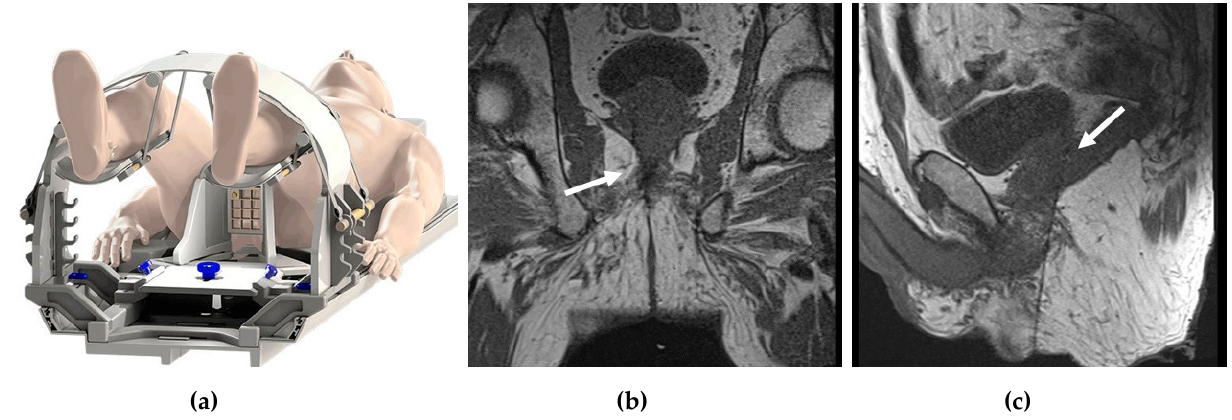
Figure 1. In-bore transperineal biopsy: ( a ) diagram of a patient placed supine in an MRI-compatible stirrups device and grid; ( b ) coronal and ( c ) sagittal T1-weighted MRI images demonstrating the needle entering the right prostate gland (white arrows).